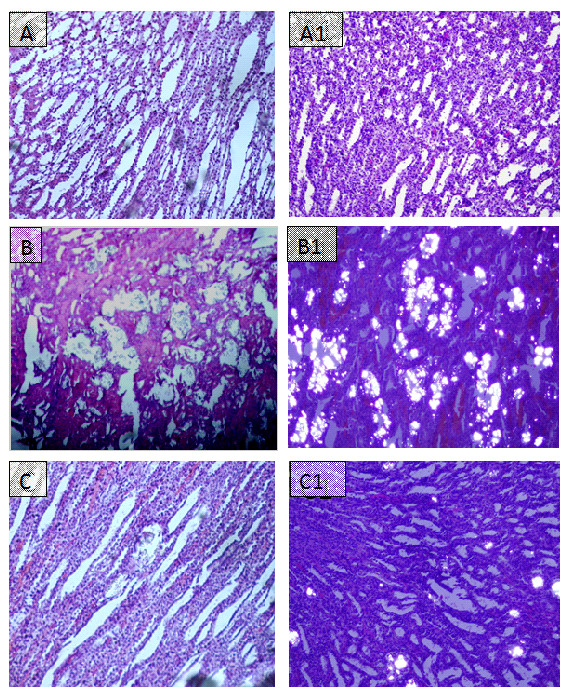
Microscopic images of Kidney sections in preventive study. Representative microscopic images of the H and E stain of the kidney sections from normal (A), Lithogenic group (B) and Treated (C) with Ov.Cr. A1, B1 and C1 show the polarized images of the sections.